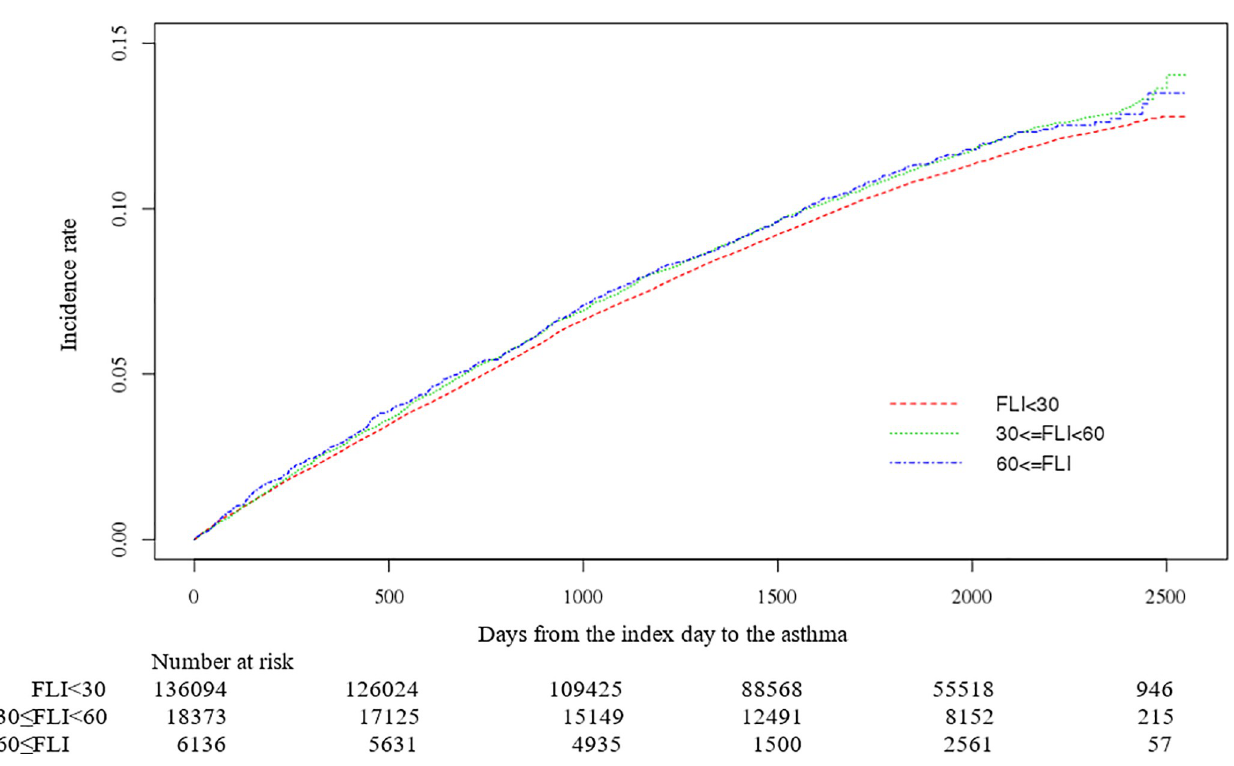
Fig 2. Cumulative incidence of adult-onset asthma by FLI group.